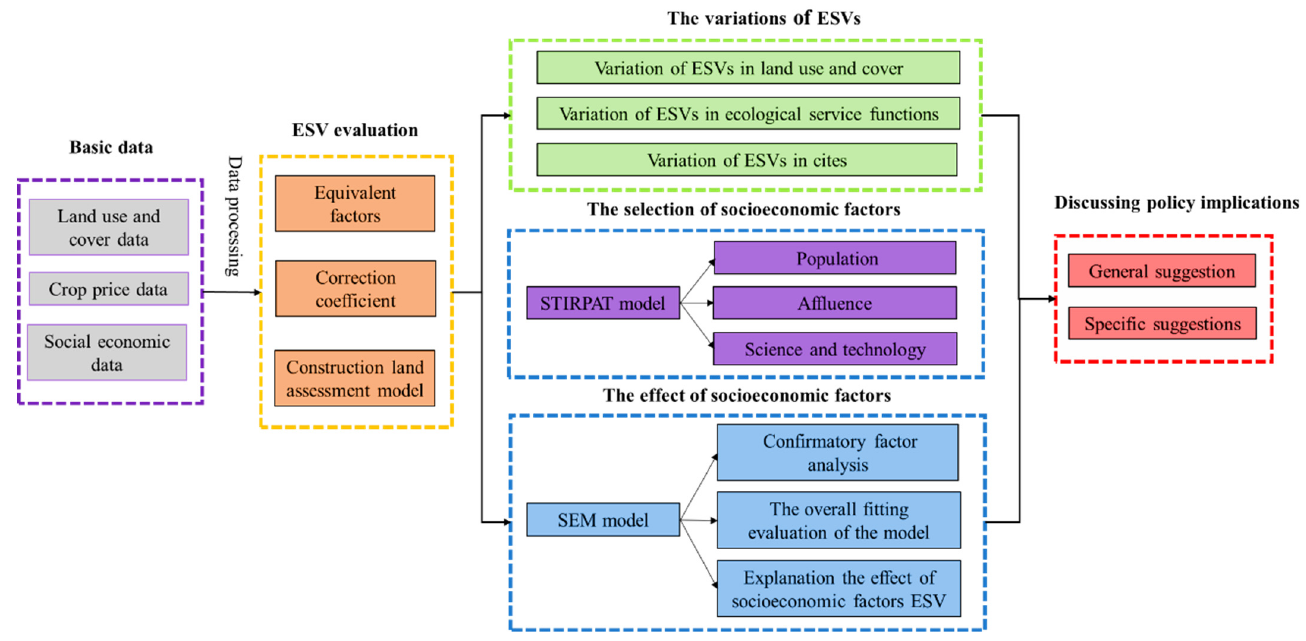
Figure 1. Research